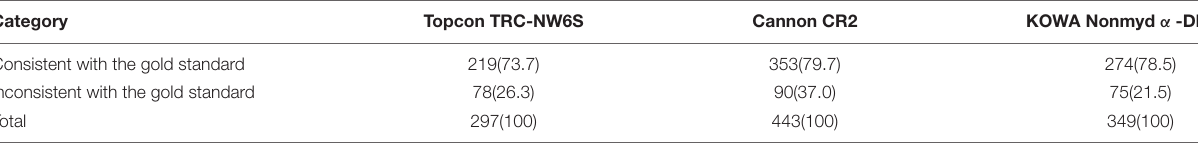
TABLE 4 | Diagnostic results of different fundus cameras.